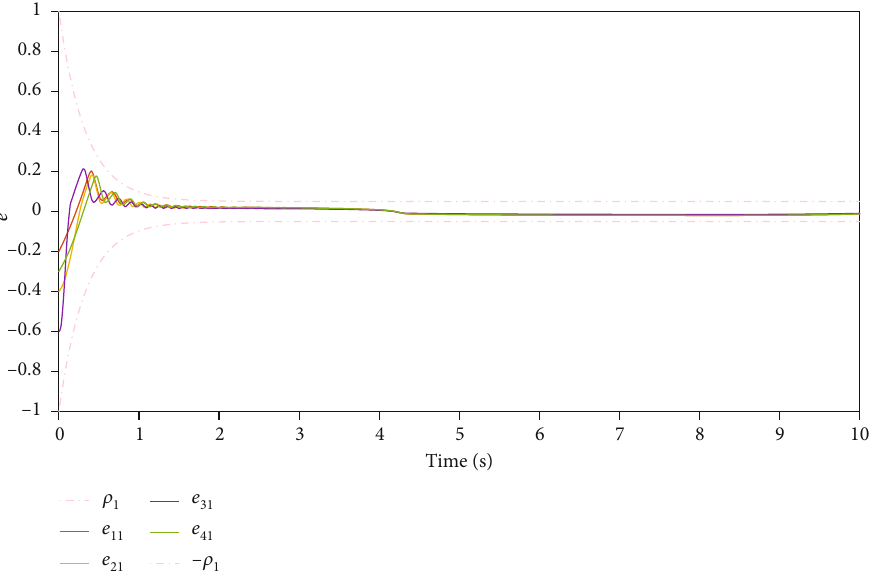
Figure 4: The error e